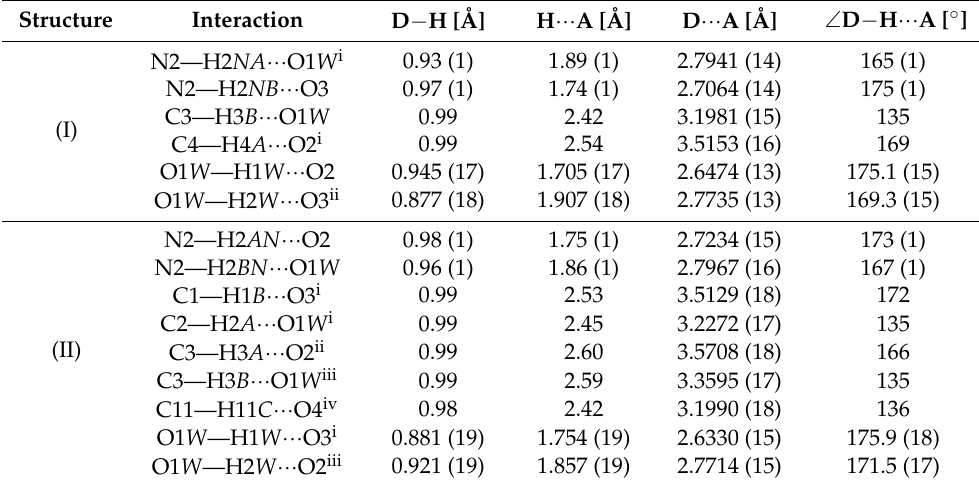
Table 1. Hydrogen-bond geometry for (I) – (III).